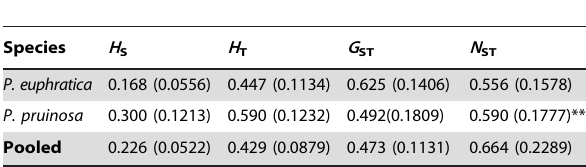
**Indicates that N ST is significantly different from G ST ( P , 0.001).